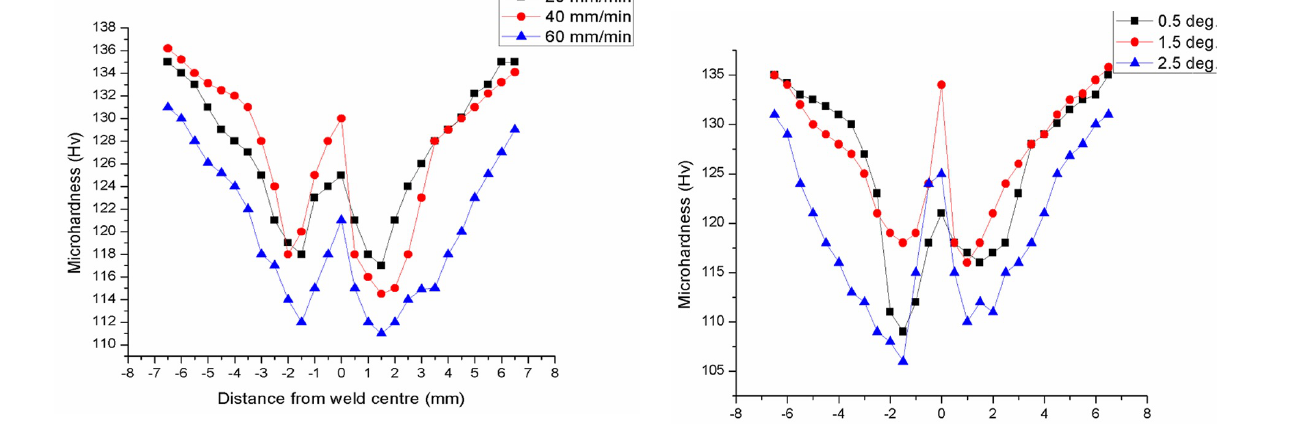
Figure 13: Effect of welding speed on microhardness proper combination of process parameters. The excessive and insufficient material flows will easily produce defects.